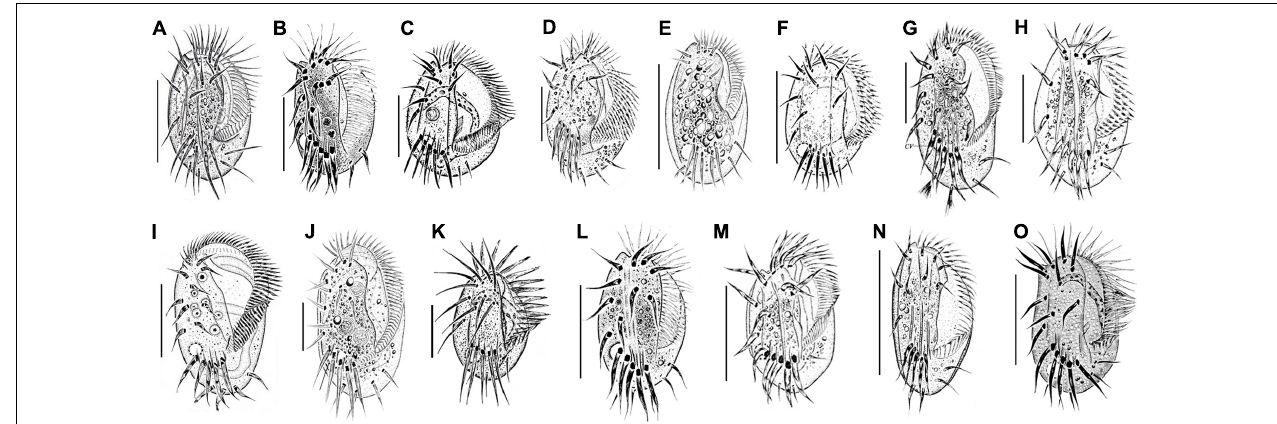
FIGURE 6 | Euplotes species collected in the coastal waters of southern China. (A) E. balteatus (Dujardin, 1841) Kahl, 1932 (from Chen et al., 2013); (B) E. bergeri Lian et al., 2020 (from Lian et al., 2020); (C) E. charon (Müller, 1773) Ehrenberg, 1830 (from Song and Packroff, 1997); (D) E. encysticus Yonezawa, 1985 (from Fan et al., 2010); (E) E. estuarinus Yan et al., 2018 (from Yan et al., 2018); (F) E. minuta (Yocum, 1930) Borror and Hill, 1995 (from Song and Wilbert, 1997); (G) E. neapolitanus Wichterman, 1964 (present work); (H) E. orientalis Jiang et al., 2010 (from Jiang et al., 2010b); (I) E. parawoodruffi Song and Bradbury, 1997 (from Shen et al., 2008); (J) E. platystoma Dragesco and Dragesco-Kernéis, 1986 (from Yan et al., 2018); (K) E. rariseta Curds et al., 1974 (from Song and Packroff, 1997); (L) E. shini Lian et al., 2020 (from Lian et al., 2020); (M) E. sinicus Jiang et al., 2010 (from Jiang et al., 2010a); (N) E. antarcticus (present work); (O) E. vannus (Müller, 1786) Borror and Hill, 1995 (from Song and Packroff, 1997). Scale bars: 50 µ m (A–G,I,J,L–O) ; 20 µ m (H,K) .